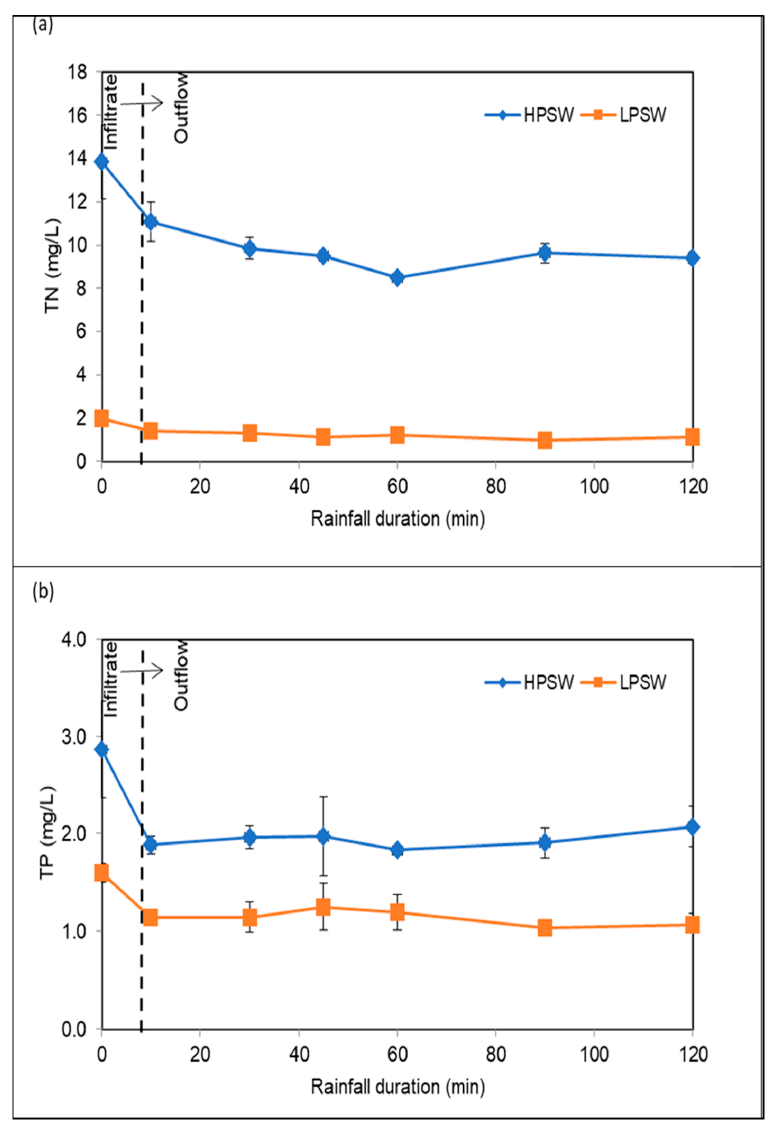
Figure 6. Variations of ( a ) TN and ( b ) TP before and after infiltration through permeable clay bricks.